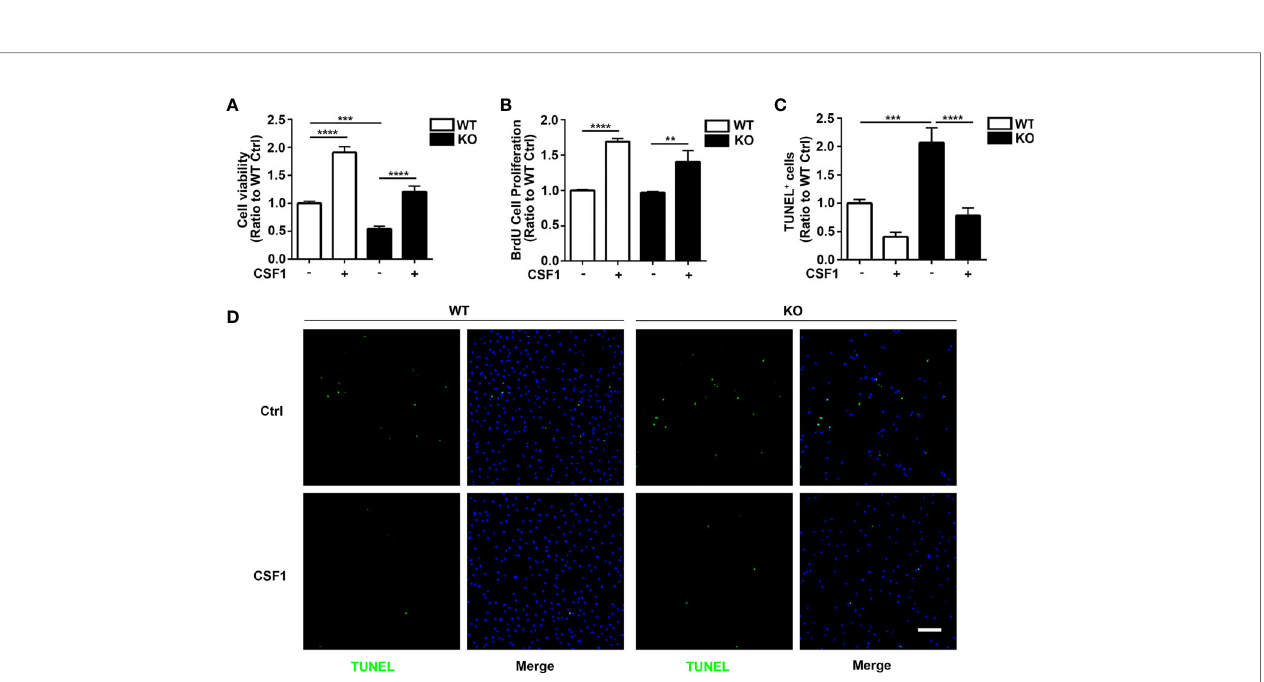
FIGURE 5 | CSF1 restores cell growth and viability in Trem2 KO microglia. (A) Cell viability of Trem2 KO microglia was enhanced in response to CSF1 treatment using MTS assays. (B) CSF1 promotes Trem2 KO microglia proliferation using BrdU incorporation assay. (C) Apoptosis and necrosis of Trem2 KO microglia were assessed by TUNEL staining. TUNEL-positive, apoptotic cells (green) were quanti fi ed as a percentage of total DAPI-positive cells (blue). CSF1 inhibited the apoptosis and necrosis of Trem2 KO microglia. (D) Representative images of TUNEL staining that co-localized with DAPI. Scale bar, 50 µm. Two-way ANOVA with Tukey ’ s multiple comparison test. Data are plotted as mean ± SEM (n=3). ** p <0.01; *** p <0.001; **** p